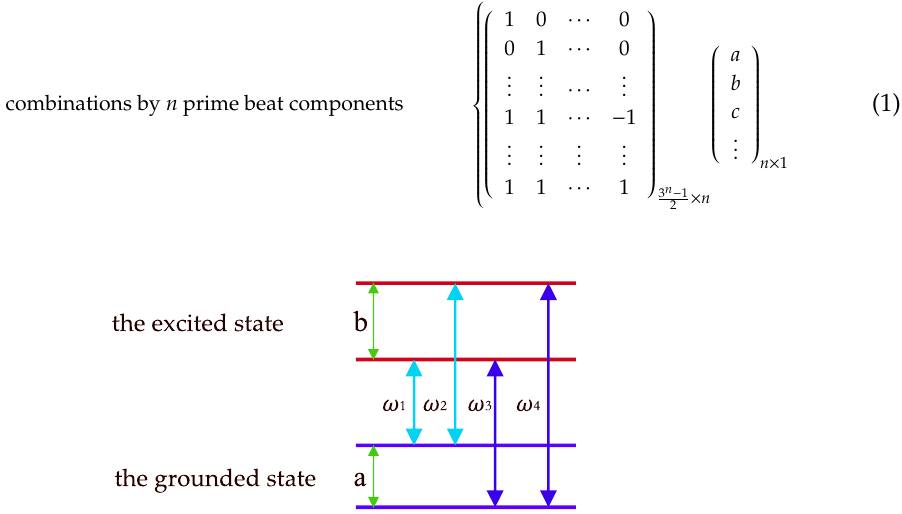
Figure 2. An example of nucleus HFS model with two prime beat components (PBC).